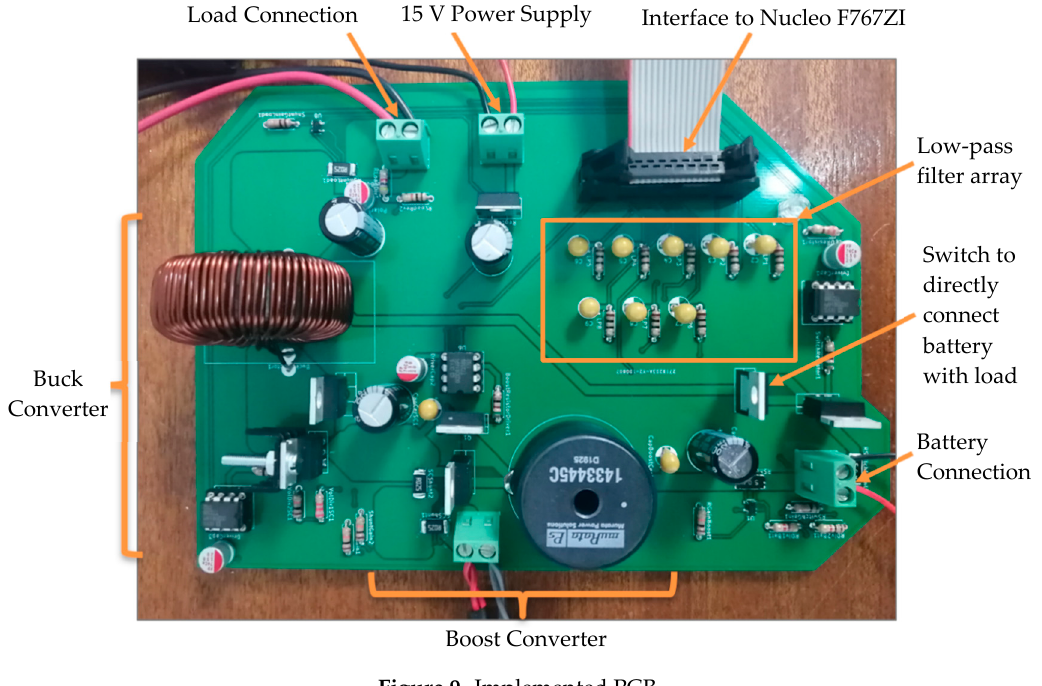
Figure 9. Implemented PCB.